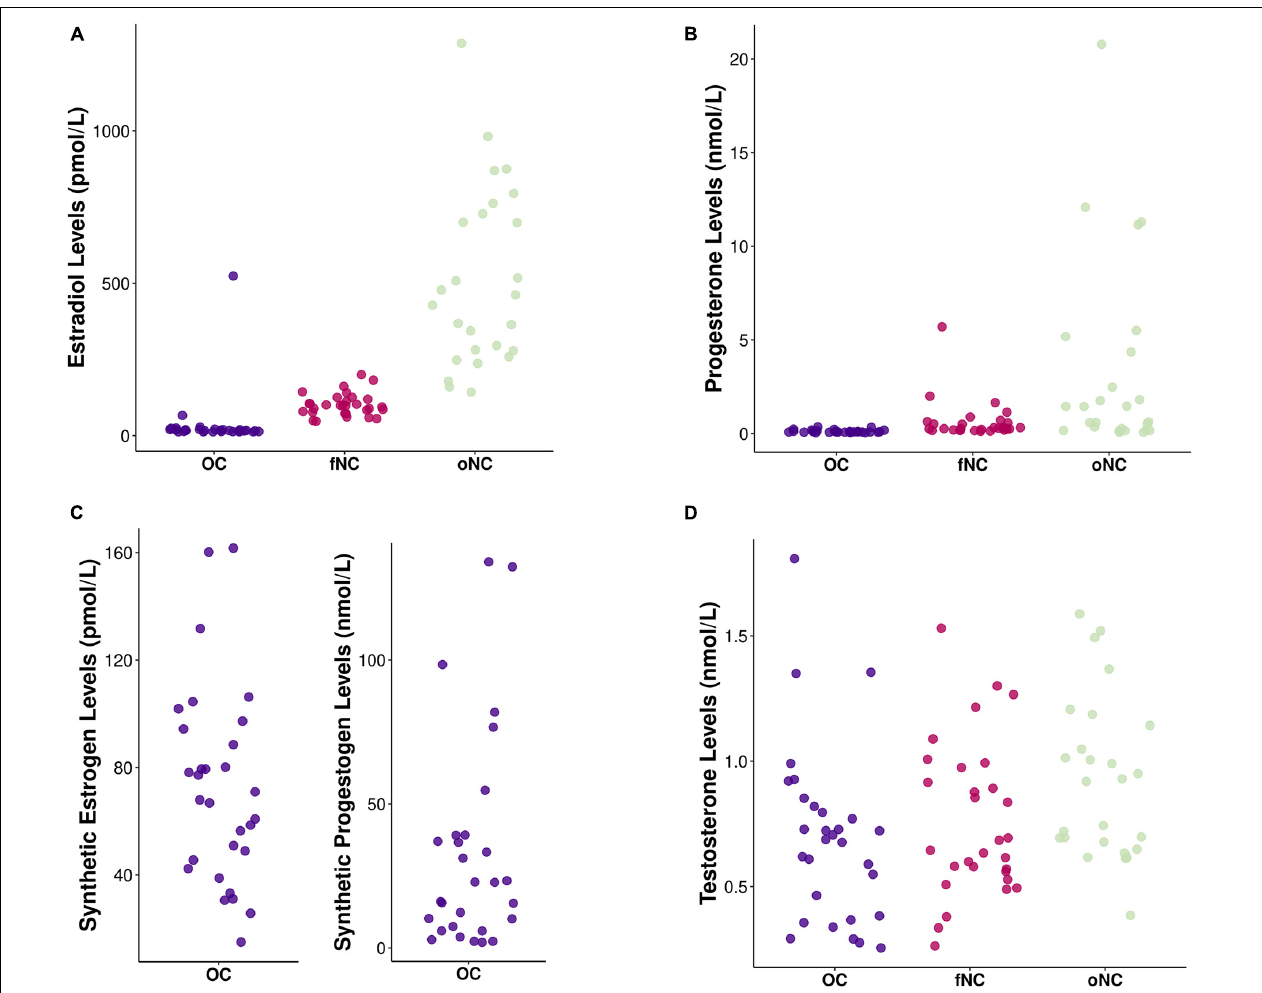
FIGURE 1 | Chart depicting hormone levels of (A) endogenous estradiol (in pmol/L), (B) endogenous progesterone (in nmol/L), (C) exogenous (i.e., synthetic) estrogens (in pmol/L) and progestogens (in nmol/L), and (D) endogenous testosterone (in nmol/L) for each hormonal status group [i.e., OC – oral contraceptive users (blue), fNC – naturally cycling women in early follicular phase (magenta), and oNC – naturally cycling women in periovulatory phase (light